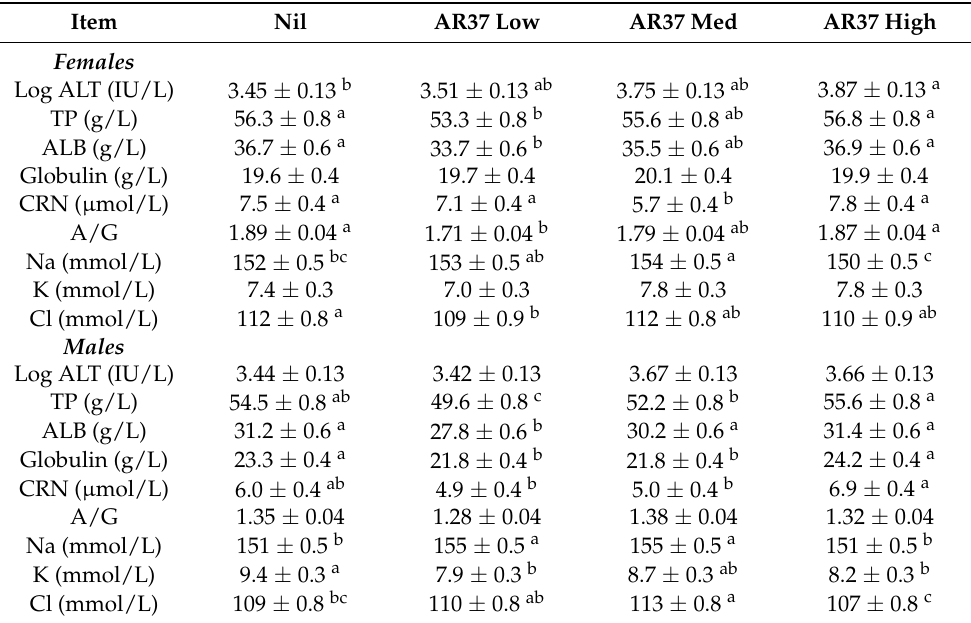
Table 7. Blood chemistry of mice fed nil, AR37 low, AR37 med or AR37 high diets (containing 0, 7.5, 15 or 30% endophyte-infected seed, respectively) for 90 days. Item Nil AR37 Low AR37 Med AR37 High Females Log ALT (IU/L) 3.45 ± 0.13